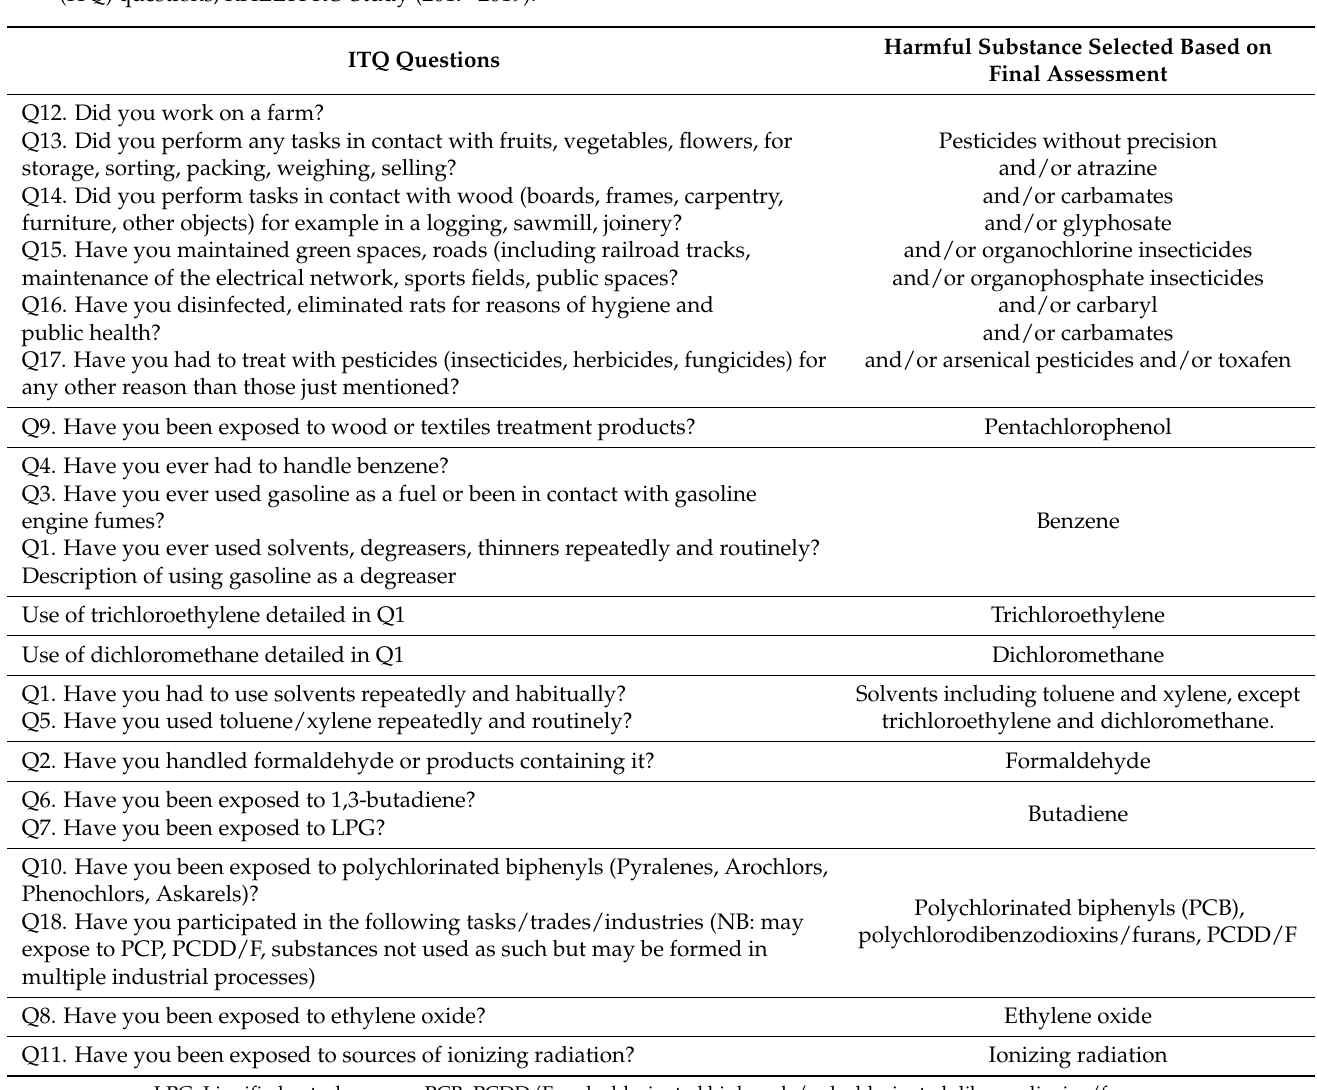
Table 1. Correspondence between the harmful substances identified by the expert’s final assessment and “tasks of interest” (ITQ) questions, RHELYPRO Study